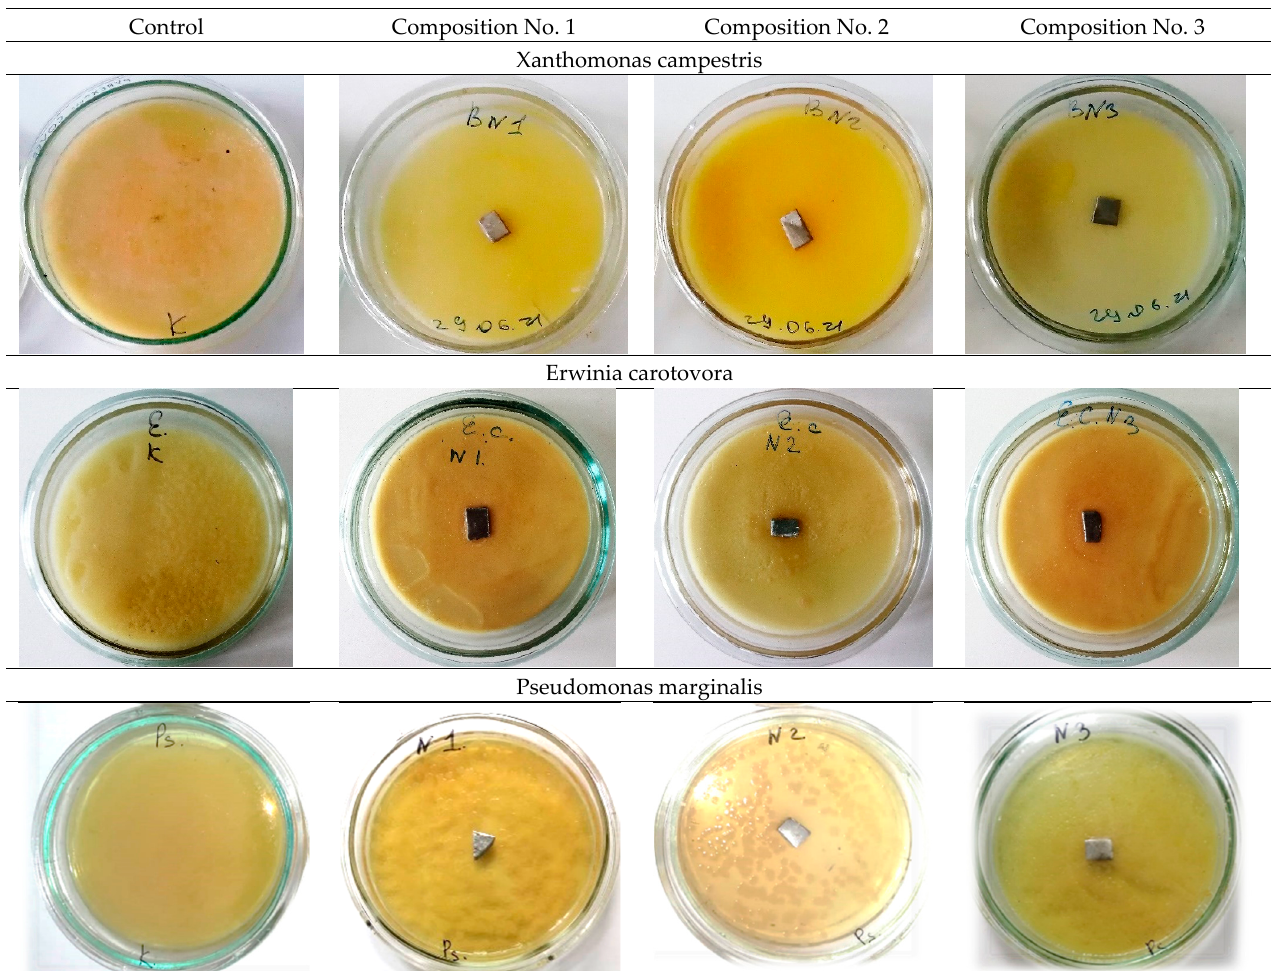
Table 2. Diameter of the sterile zone of the samples.